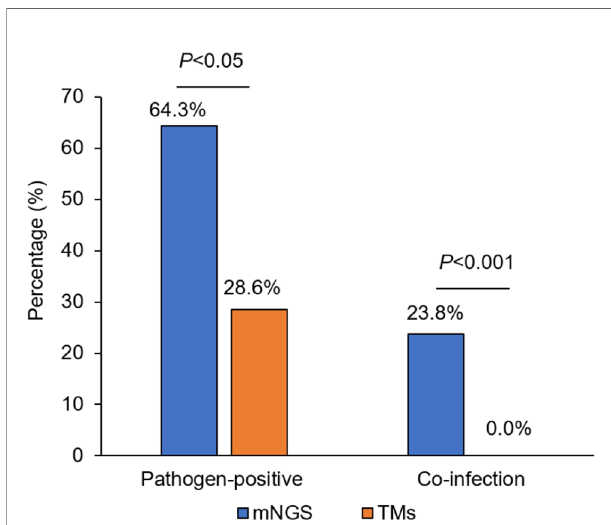
FIGURE 1 | The comparison of pathogen-positive percentage and co- infection rate detected separately by mNGS and TMs in liver donors. mNGS for metagenomic next-generation sequencing and TMs for traditional laboratory